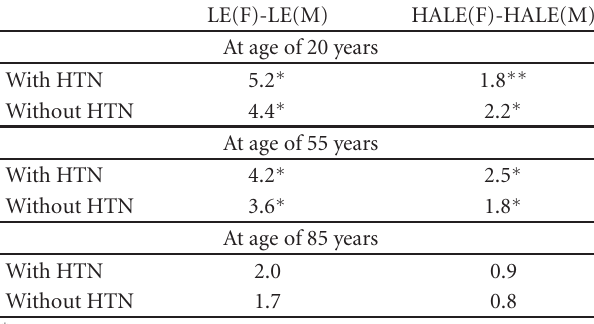
Table 1: Di ff erence in life expectancy (LE) and health-adjusted life expectancy (HALE) between females and males with and without hypertension (HTN) for selected ages, Canada, 2004 to 2006. (Dataset for this study excluded Quebec, Nunavut and Northwest